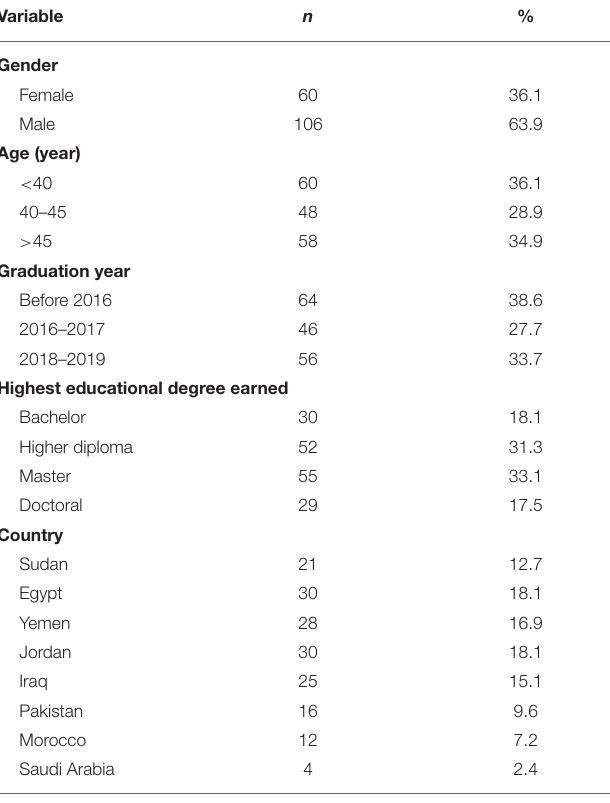
TABLE 1 | The characteristics of 166 Field Epidemiology Training Program (FETP) graduates in